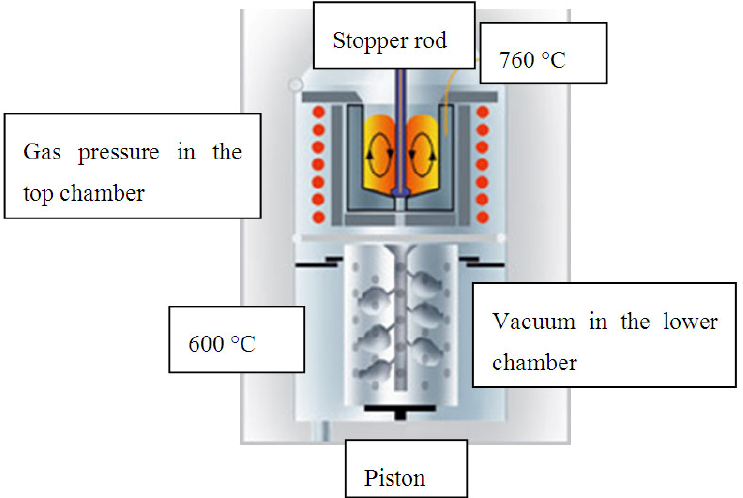
Figure 17. Schematic of the pressure-assisted vacuum investment casting process, adapted from